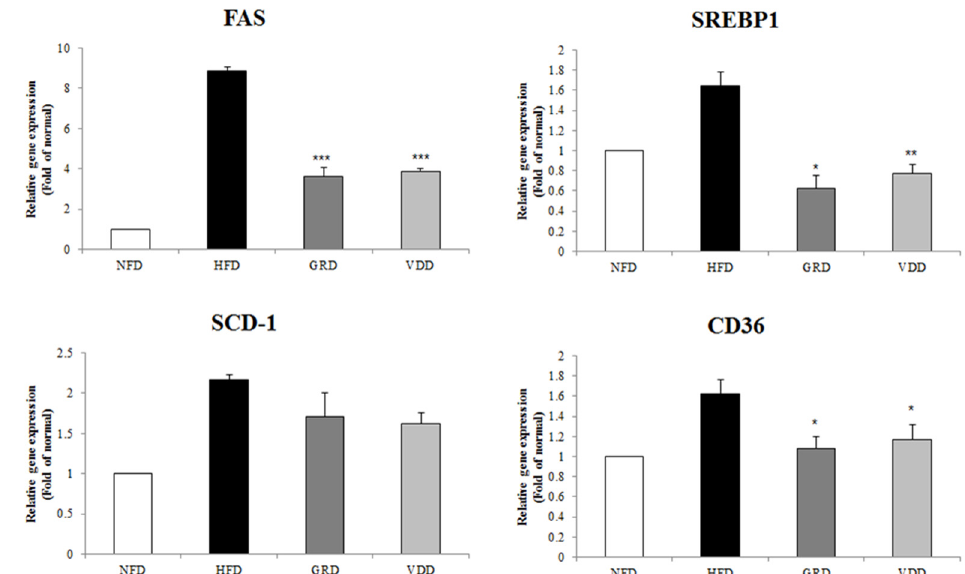
Figure 5. Effects of Valeriana dageletiana Nakai ex F. Maek extract from above-ground part (VDAE) on mRNA expression of lipogenesis-related genes in liver. Results are presented mean ± SE. The asterisk indicates a significant difference compared to HFD group (* p < 0.05, ** p < 0.01, *** p < 0.001). NFD; normal fat diet control, HFD; high fat diet control, GRD; HFD + 1% Garcina cambogia extract, VDD; HFD + 1% Valeriana dageletiana Nakai ex F. Maek extract from above-ground part.